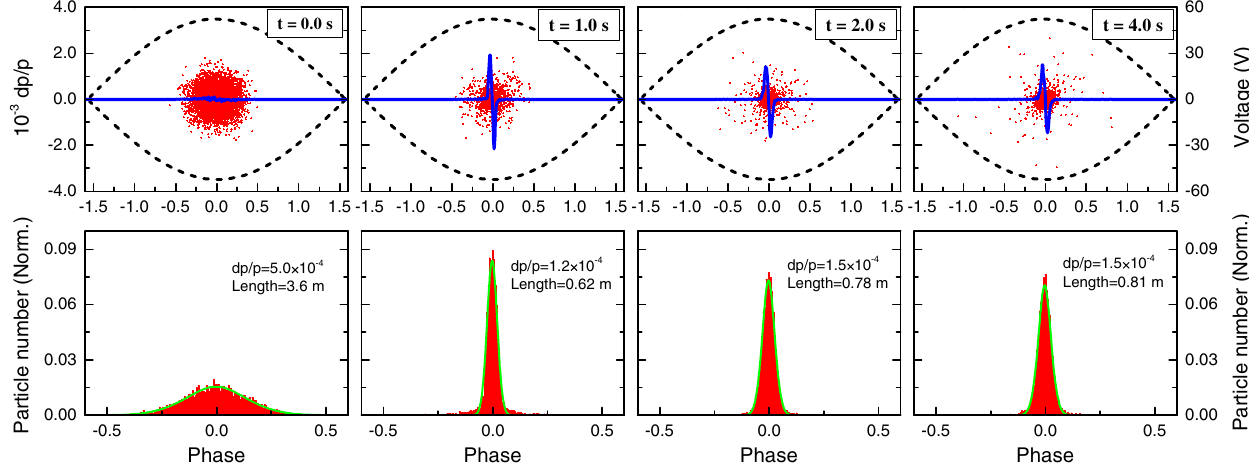
FIG. 3. Evolution of the model particles distribution in longitudinal phase space (red dot), the space-charge potential (blue line) and the particles distribution in the longitudinal for one bunch of 12 C 6 þ beam in CSRm. The black dashed line is the rf bucket with ¼ 1 . 0 kV and the green line is the fitting result by the Fokker-Plank equation. The fitting result of bunch length and momentum V rf spread is given.